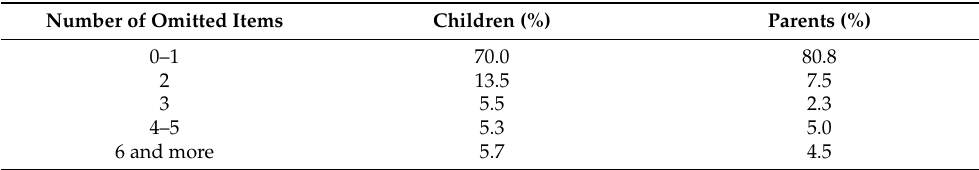
Table 3. Frequencies of missing data for children and parents (Group B) in the diet section of the questionnaire (number of items was